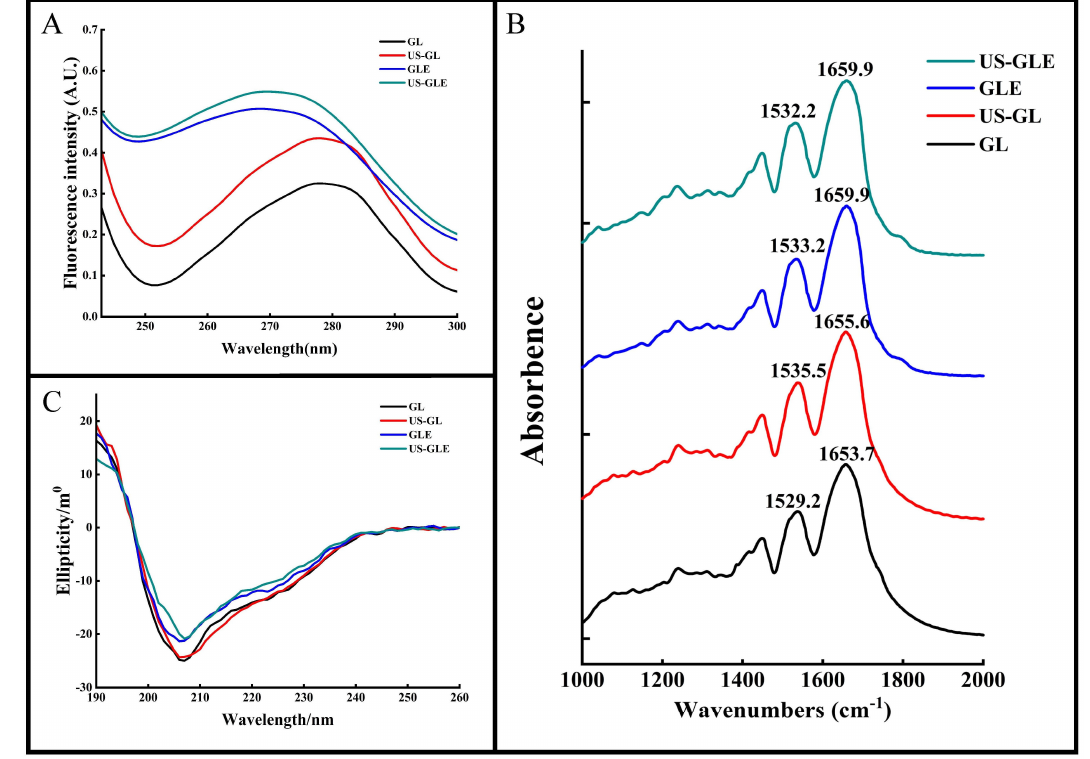
Figure 2. Structural analysis of samples. Ultraviolet absorption (UV-Vis) ( A ), Fourier transform in- frared (FT-IR) ( B ) and circular dichroism (CD) ( C ) spectra of GL, US-GL, GLE and